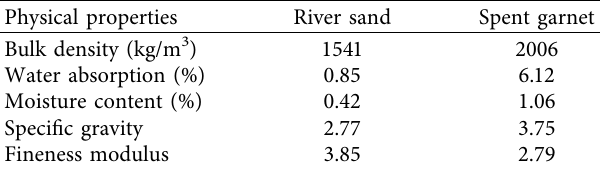
Table 2: Physical properties of river sand and spent garnet.